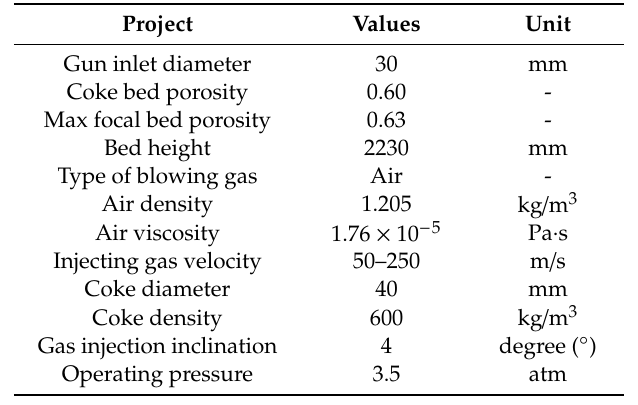
Table 1. Parameters used in this